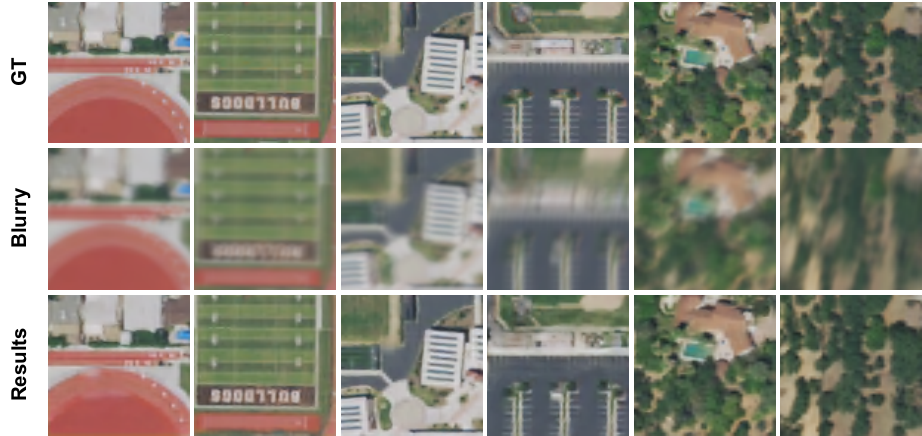
Figure 12. The images restored by Ref-MFFDN of size 96 × 96